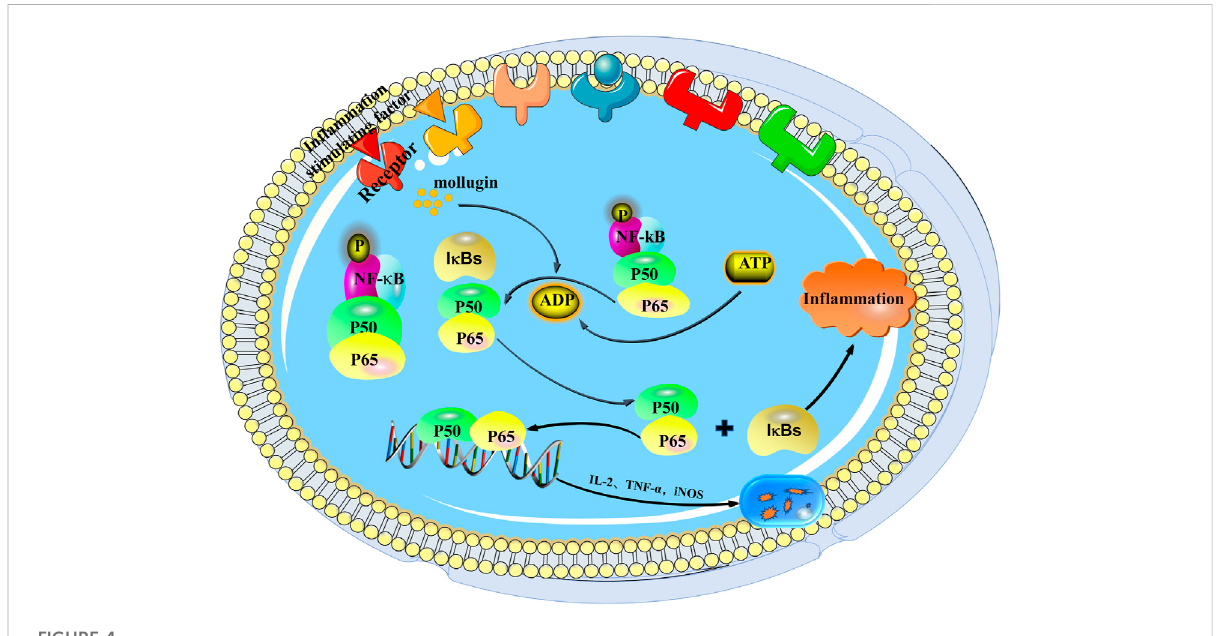
FIGURE 4 Anti-in fl ammatory mechanism of mollugin.